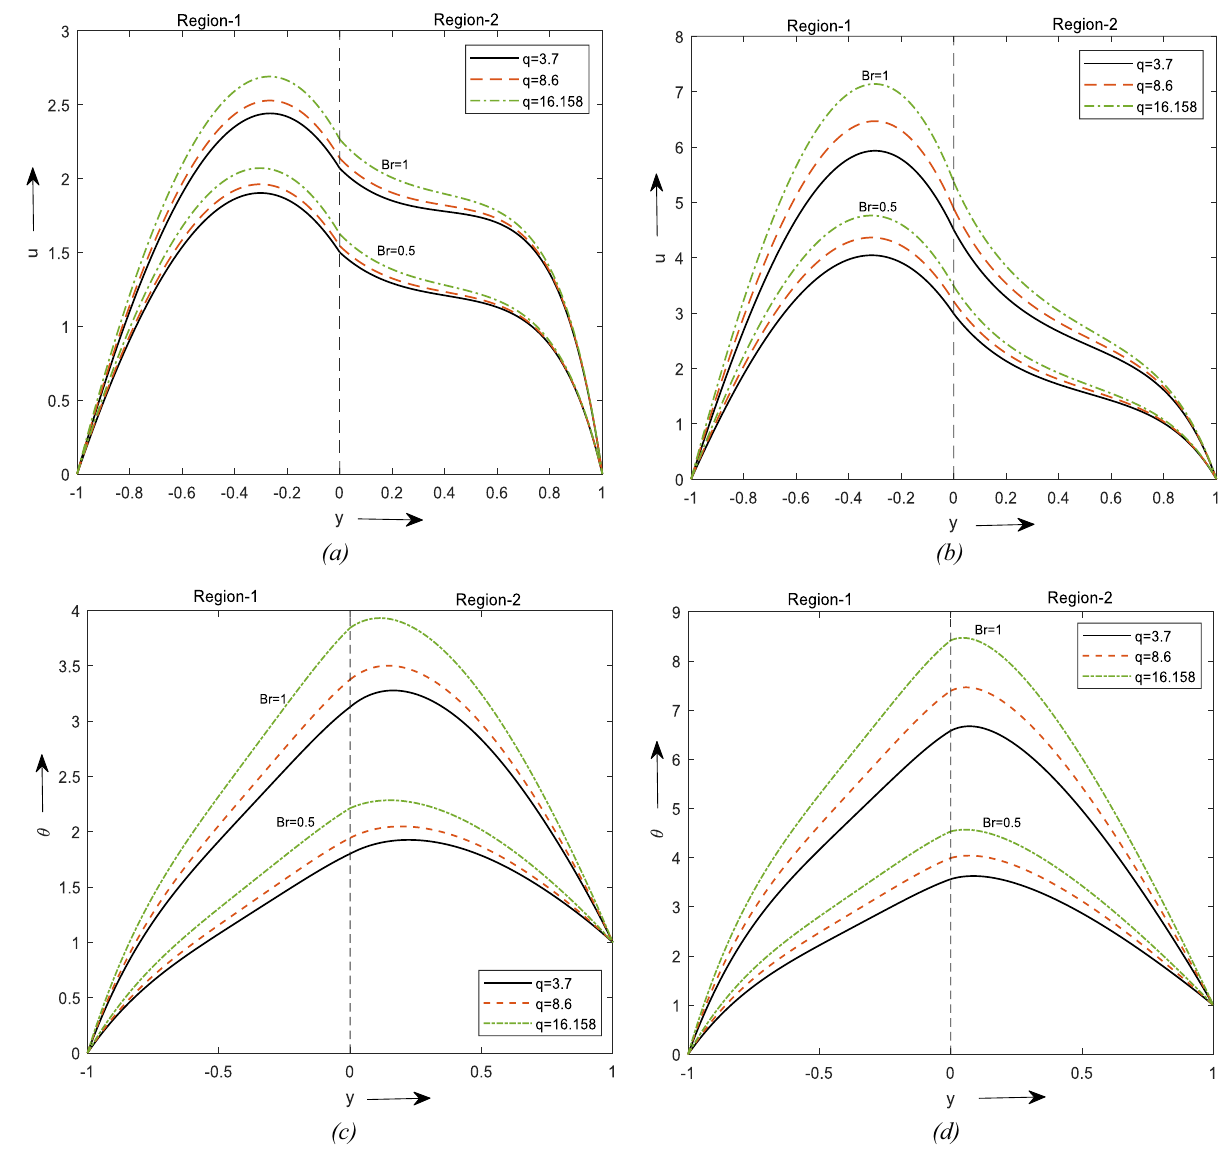
Figure 3. Velocity profiles for different values of Br. ( a ) For two different values of φ . ( b ) For a value of φ . Temperature profiles for different values of Br. ( c ) For two different values of φ . ( d ) For a value of φ